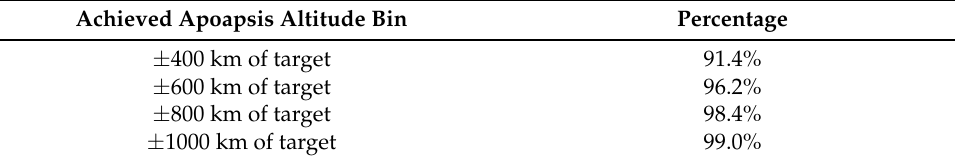
Table 11. Statistics for Venus aerocapture orbit apoapsis altitude.